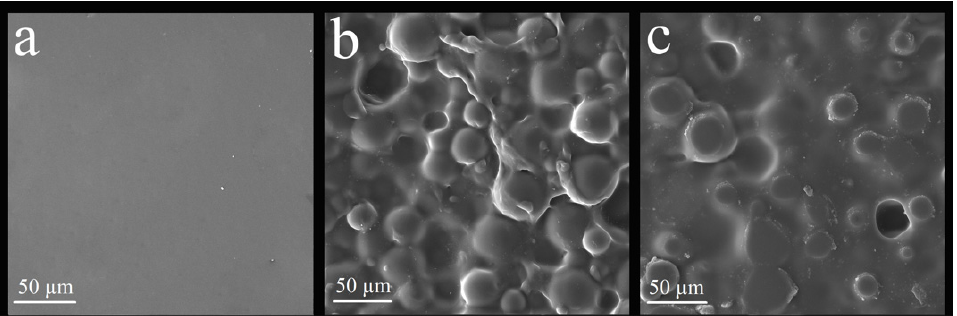
Figure 7. Images obtained by SEM-EDX of the surface of the nanocomposites of the experimental groups relative to the reliner: ( a ) CR group, ( b ) R1 group, and ( c ) R2 group.